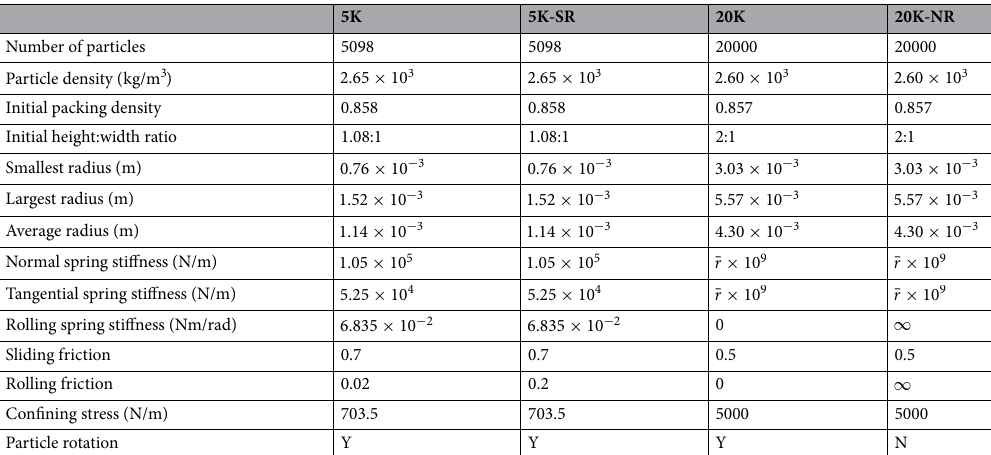
Table 2. DEM simulation parameters and material properties for the four studied samples. Identical initial conditions are applied in samples 5K and 5K-SR, except for that 10 times larger rolling friction is used in sample 5K-SR, which results in suppression of rotation. Samples 20K and 20K-NR share the same initial conditions and differ only in particle rotation, which is blocked in 20K-NR. The contact stiffness for 20K